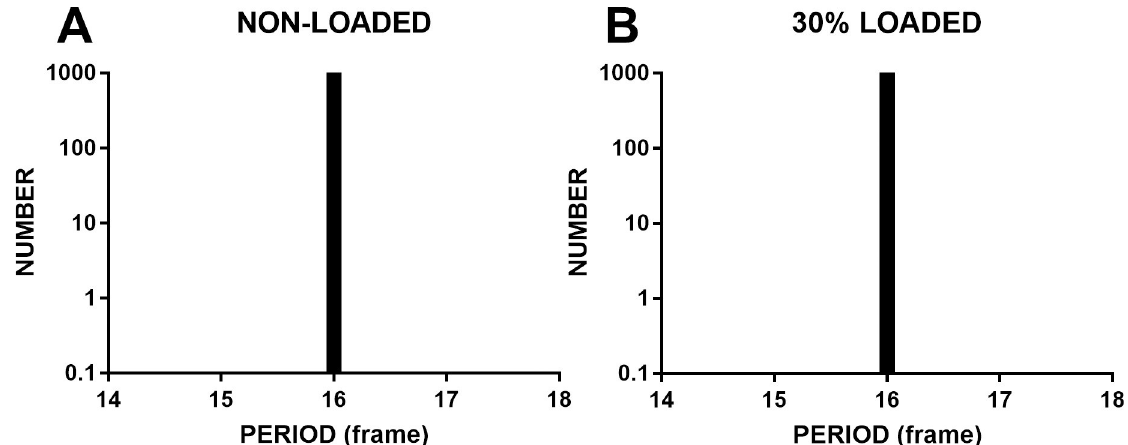
Fig 6. The timing accuracy of the dynamic sinusoidal grating designed by rAF run at 30% of the CPU utilization rate. The priority was set to the real-time level, and the refresh rate was 60 Hz. There is only one bar standing at the 16th frame, which indicates that the timing accuracy (mean = 16.0 frames, SD = 0.001 frames, range = 0.004 frames, FLR = 0.00%) was very high at 30% of the CPU utilization rate.